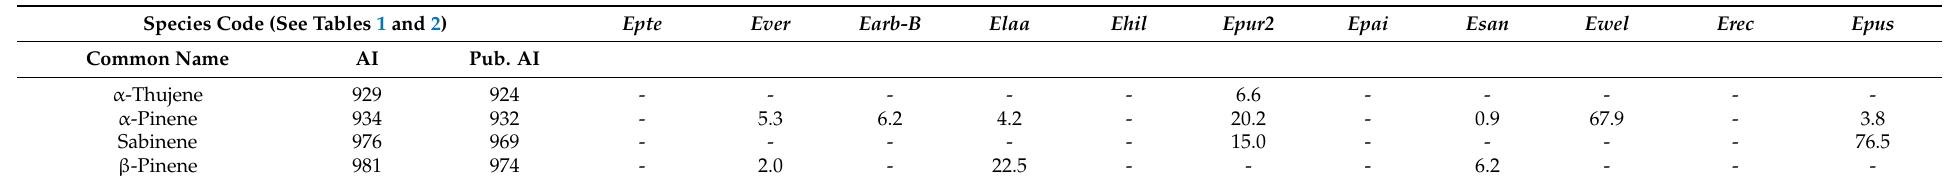
Table 11. Chemistry of solvent extract volatiles; Eremophila pterocarpa (Epte), E. veronica (Ever), E. arbuscular (Earb), E. laanii (Elaa), E. hillii (Ehil), E. purpurascens (Epur), E. paisleyi (Epai), E. santalina (Esan), E. weldii (Ewel), E. recurva (Erec), and E. pustulata (Epus). Species Code (See Tables 1 and